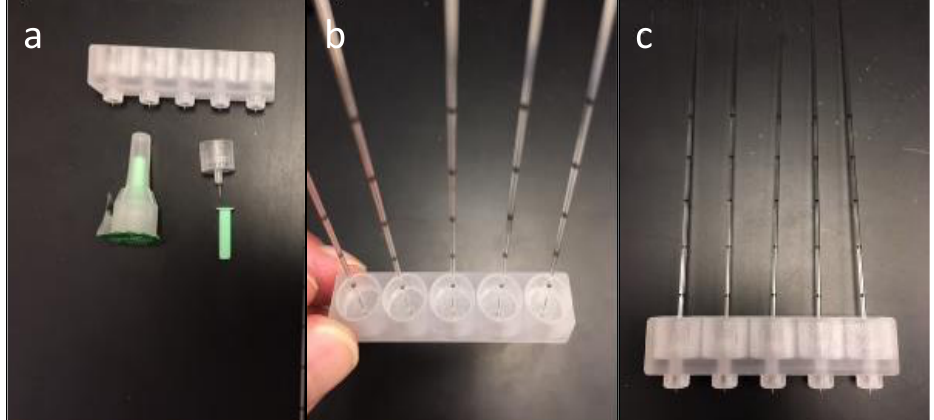
Figure 1. MA Design. Microneedle, capillary, and MA with needles inserted. ( a ) Top ( b ) and side ( c ) views of fully assembled MA.